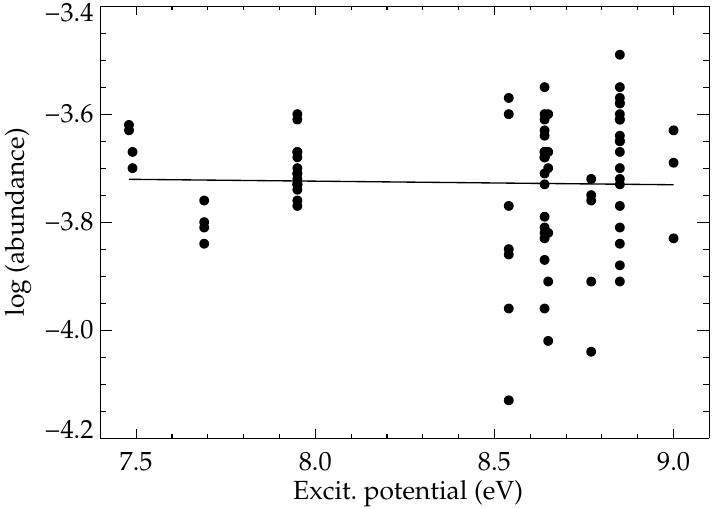
Fig. 3. The dependence of the carbon abundance on the C I line lower excitation potential. The plot is made for a microturbulent velocity of 6.8 km s − 1 and T eff = 6000 K. effective temperature T eff = 6000 (cid:6) 100 K and the microturbulent velocity (cid:24) t = 6 : 8 km s − 1 (Figures 2 and 3). With these parameters the carbon abundance